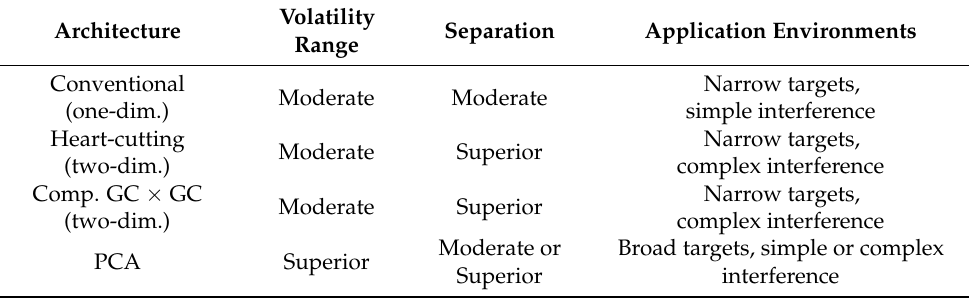
Table 1. General comparison of µ GC architectures under limited energy